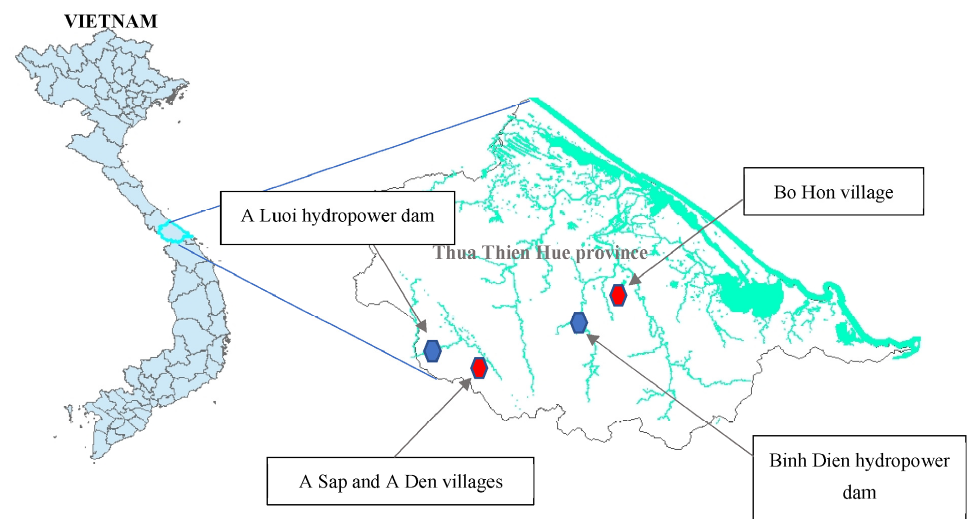
Figure 2. Map of case studies in Bo Hon, A Sap, and A Den villages, Thua Thien-Hue province,